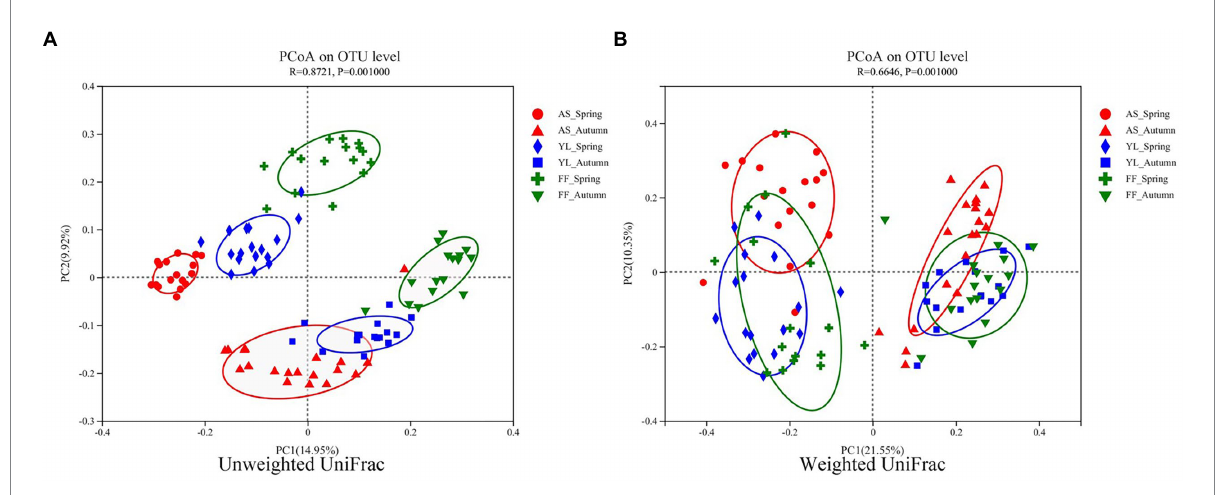
FIGURE 3 PCoA of phyllosphere fungal communities based on the (un)weighted UniFrac distance matrixes (A,B) among AS, YL, and FF in spring and